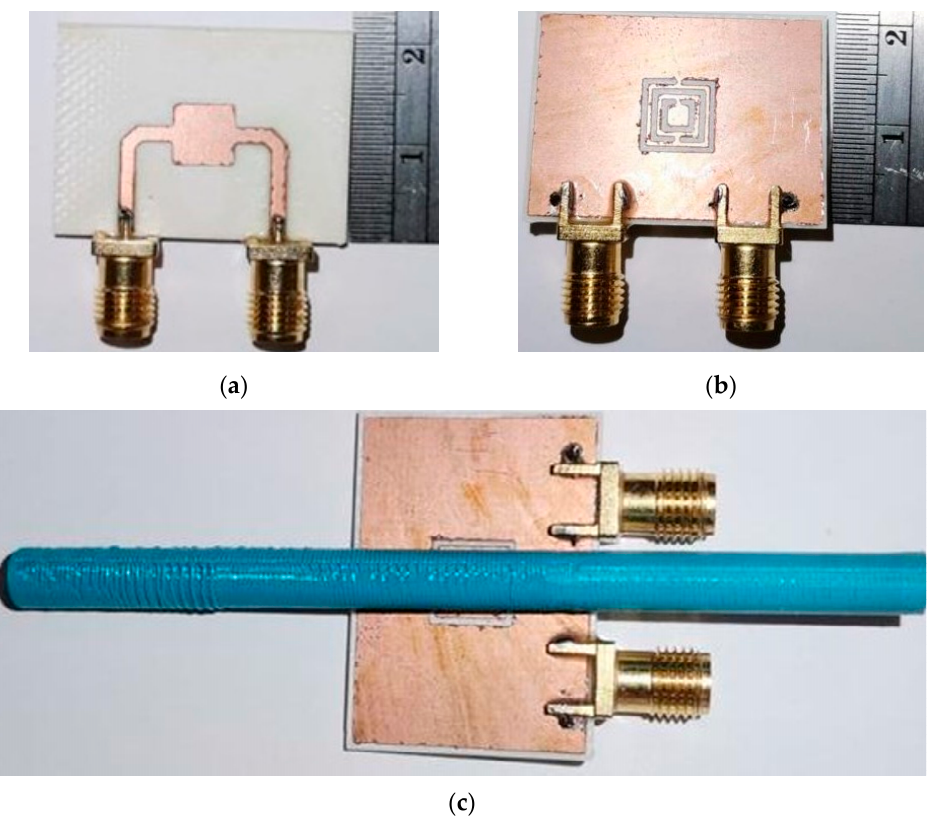
Figure 5. Fabricated sensor prototype: ( a ) top view; ( b ) bottom view; ( c ) flat sensor with embedded tube.